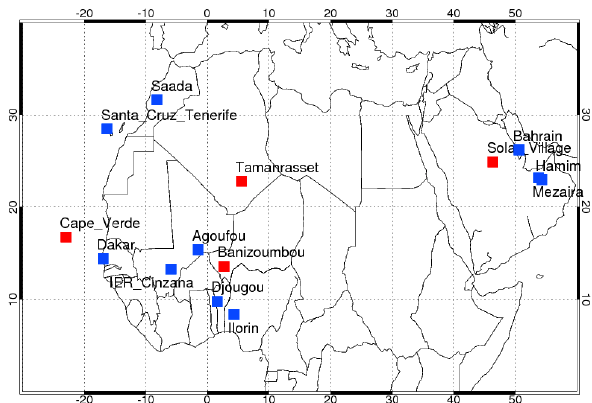
Fig. 1. The domain map and site location of the 14 AERONET sites selected for this study. Four sites marked with red squares are used for detailed analysis (see